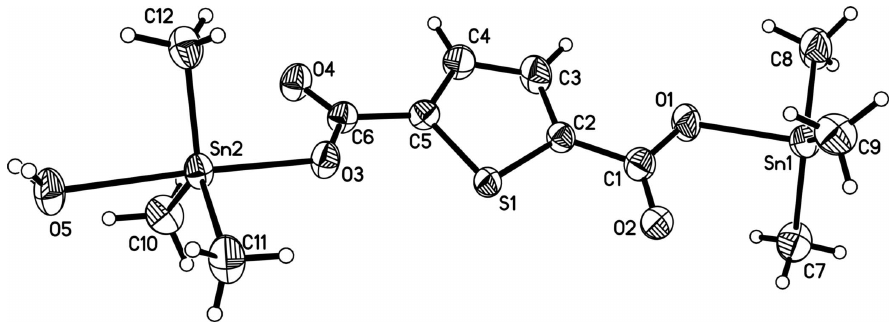
Figure 1 A portion of the polymeric chain of the title compound showing the atomic numbering and 30% probability displacement ellipsoids.